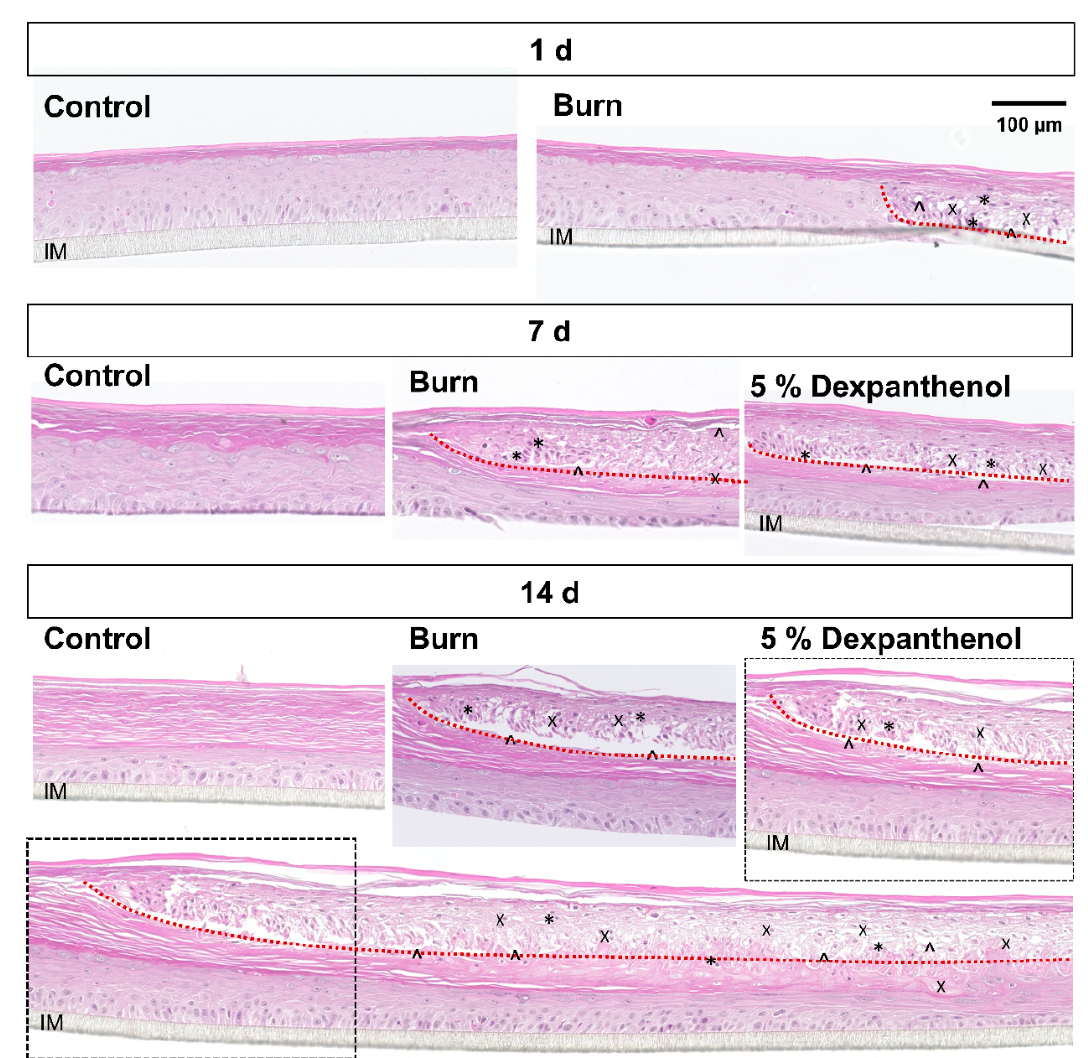
Figure 2. Histological analysis of wound healing. Haematoxylin and Eosin staining of cross sections. Histology showed a clear wound edge (indicated by dotted line), separation of strata (^), swelling of cells (X) and pycnotic nuclei (*) 1 day after burning. On day 7 and day 14, wound closure could be observed. Images in the boxes show the same region of the model. The wound edge is progressing under the remaining dead tissue. During the healing process a new epidermis is formed, containing all layers. (Images from 1 out of 3 biological replicates in independent test runs with 1 technical replicate each). We also analyzed the presence of proliferative cells using an antibody against Ki67 (Figure 5; Supplementary Figure S4). Ki67 stains the nucleus of proliferating cells and is observed on the basal layer of the tissue. Within the control group, approximately 21% (SD = 8.18%) of the basal keratinocytes were Ki67 positive (Figure 5). One day after the burn process, there was still a positive signal in the burned area. However, the morphology of the nuclear staining was affected by the thermal stress and Ki67 positive nuclei appeared more elongated. On day 7 and day 14 new Ki67 positive tissue had emerged from the wound edge, growing under the damaged tissue and extending further into the burned area with time. After 14 days of culture, 18% (SD = 2.34%) of the cells in the newly formed tissue of burned OS-REp were positive, whereas 24% (SD = 0.77%) of the cells in the burned models treated with dexpanthenol showed positive staining for